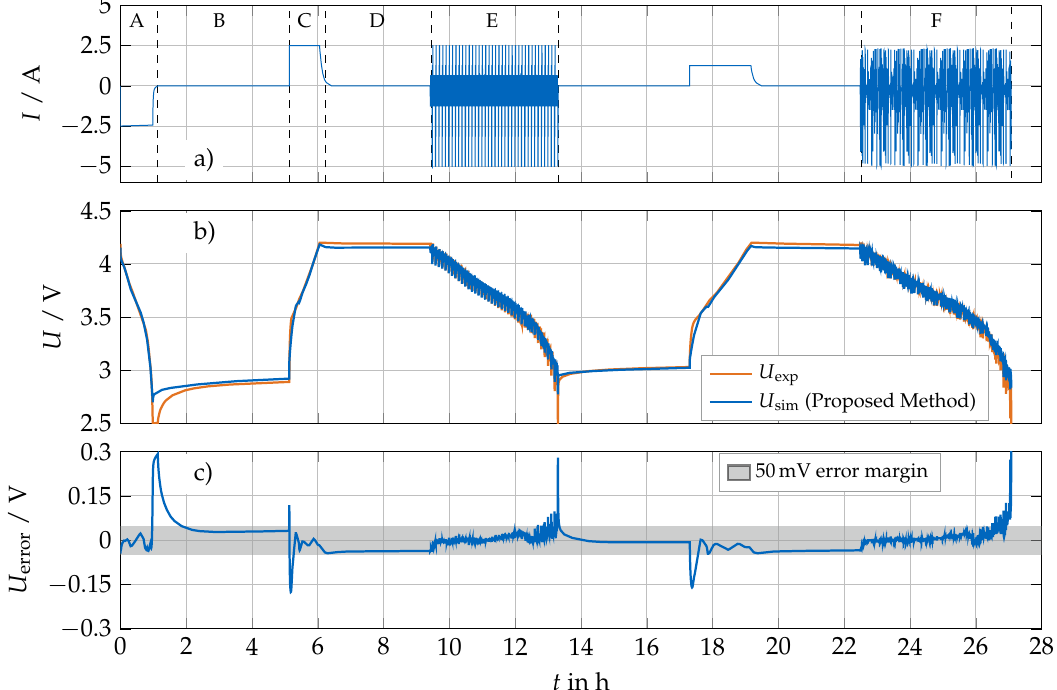
Figure 7. Simulation results of the combined DRT-fitting during the validation cycle. ( a ) Current profile. ( b ) Measured and simulated voltage. ( c ) Model error U error = U sim